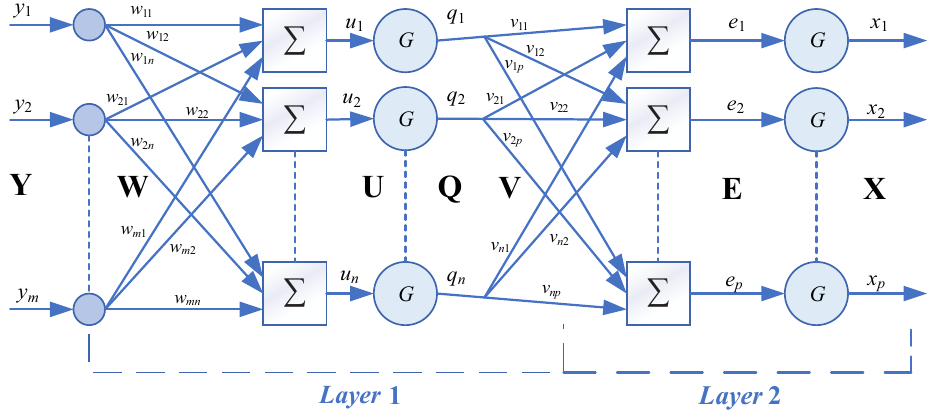
Figure 6. The architecture of a two-layer ANN with